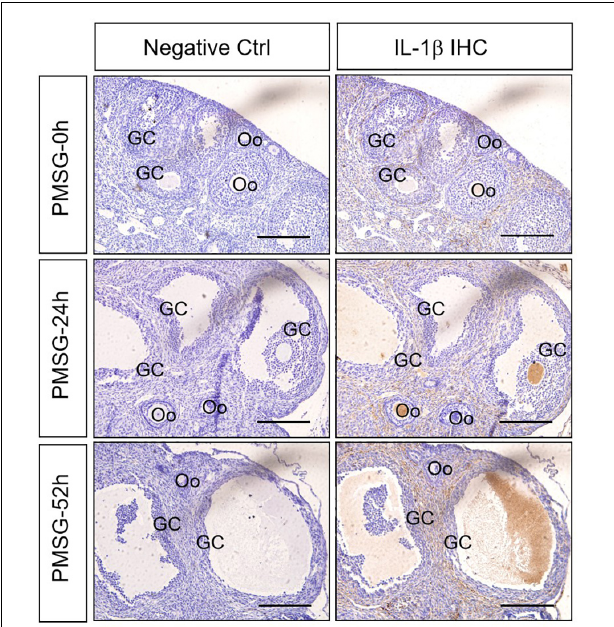
FIGURE 5 | IL-1 β Immunohistochemistry in the ovary during the follicular development induced by PMSG Ovarian sections were immunostained for IL-1 β and counterstained with hematoxylin. The IL-1 β immunohistochemical signals appear brown, and the background counterstaining appears blue. Negative control remained unstained, lacking primary antibody instead of serum. GC, granulosa cell; Oo, oocyte; bar = 100 µ m.